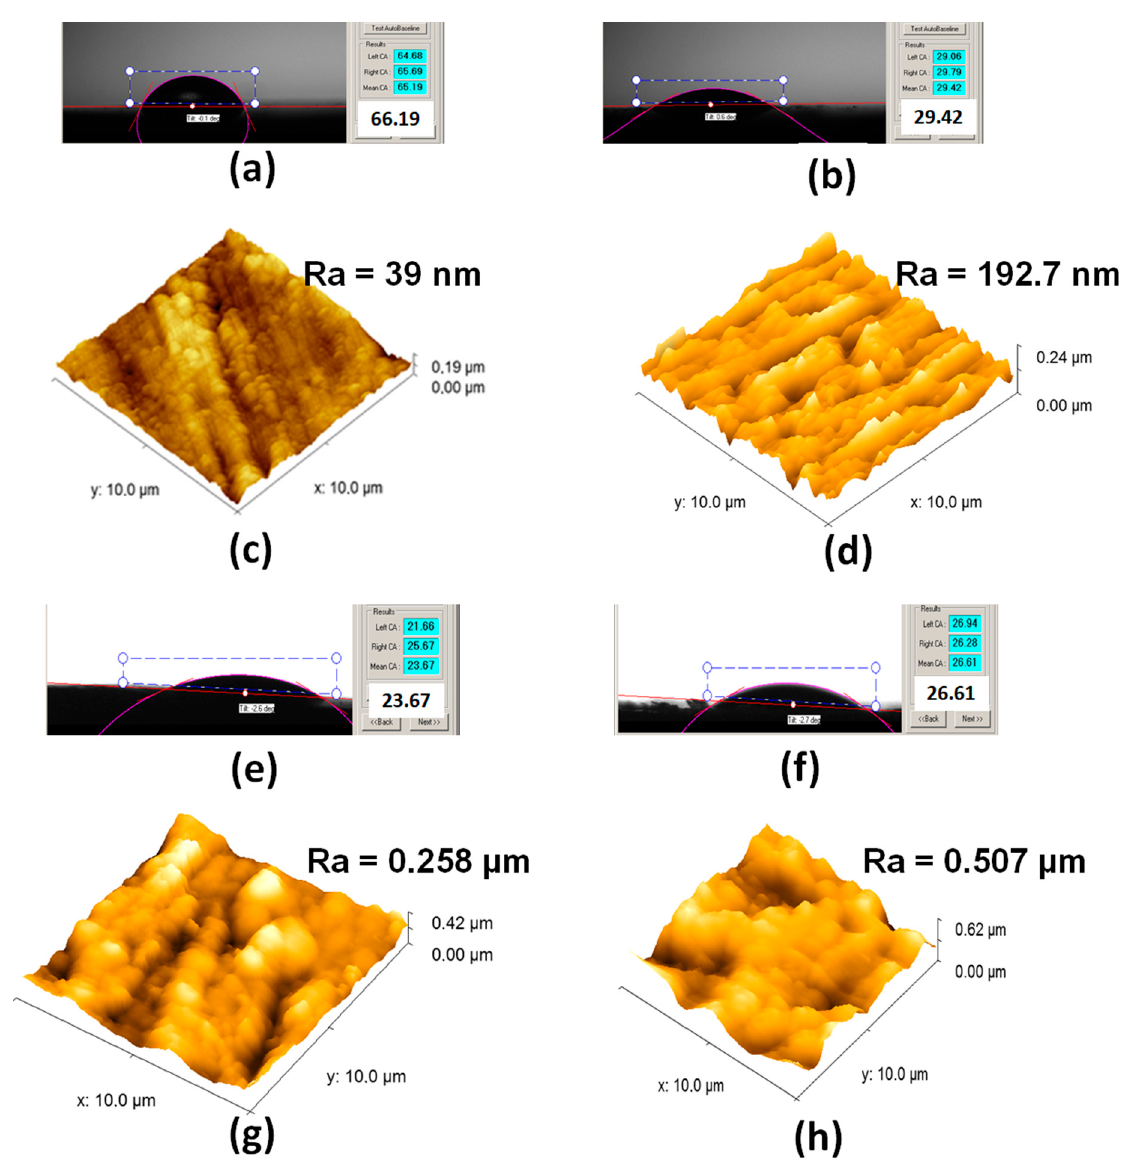
Figure 3. Average contact angle and 3D AFM images with obtained Ra values for: ( a , c )—Ti, ( b , d )—TiNT, ( e , g )—TiNT GO, ( f , h )—TiNT GO